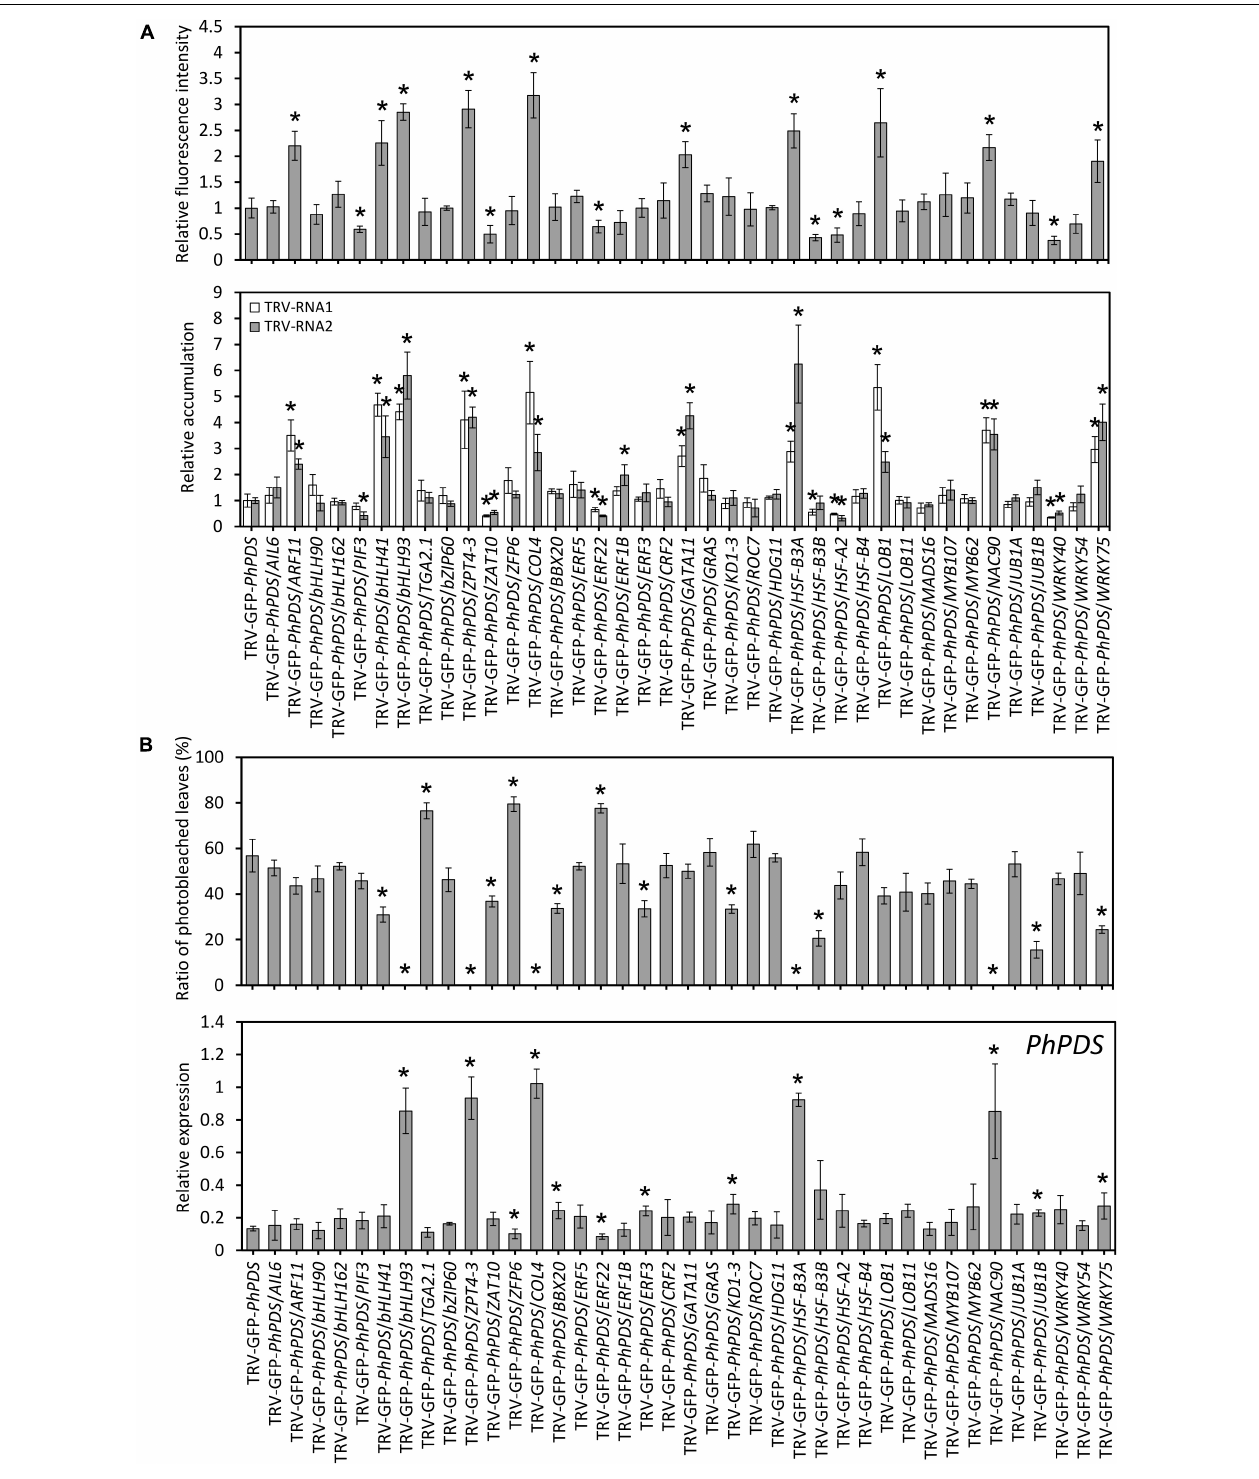
FIGURE 7 | Virus accumulation and silencing efficiency in various transcription factors-silenced petunia leaves. (A) Relative GFP fluorescence intensities and TRV (RNA1 and RNA2) accumulation levels in the inoculated leaves at 4 days post inoculation (dpi) with Agrobacterium containing 39 transcription factors (TFs)-inserted TRV-GFP- PhPDS plasmids. (B) Percentage of photobleached leaves and expression of PhPDS in the uppermost leaves at 14 dpi with Agrobacterium containing various constructs. 26S rRNA was used as an internal control. Error bars represent standard error of the mean from three biological replicates. Asterisks indicate statistical significance as determined by Student’s t -test at P <